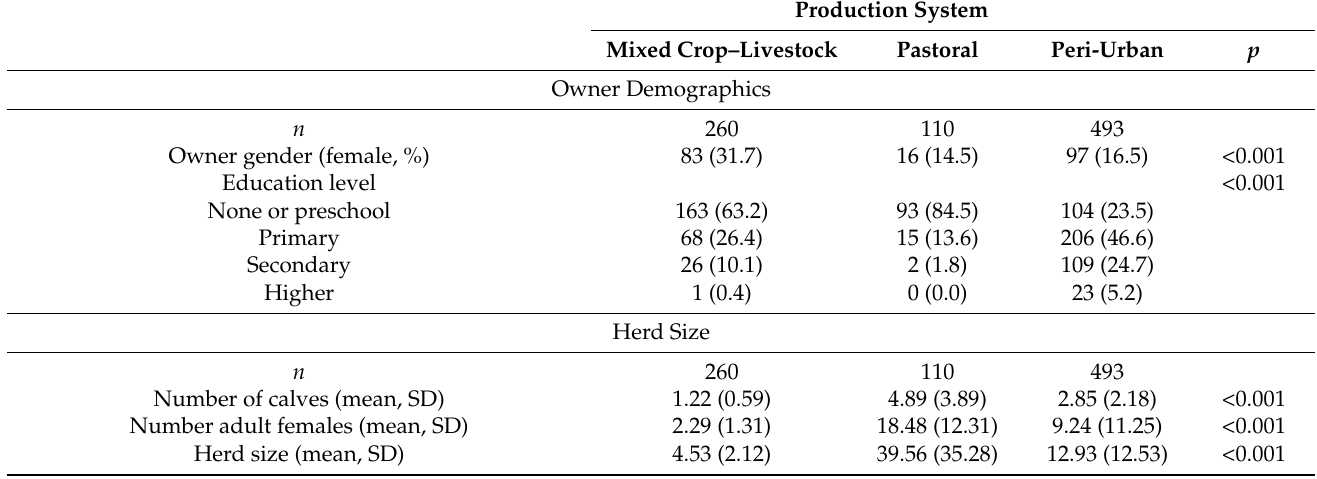
Table 3. Household demographics, herd sizes, and production practices for households enrolled in the epidemiological